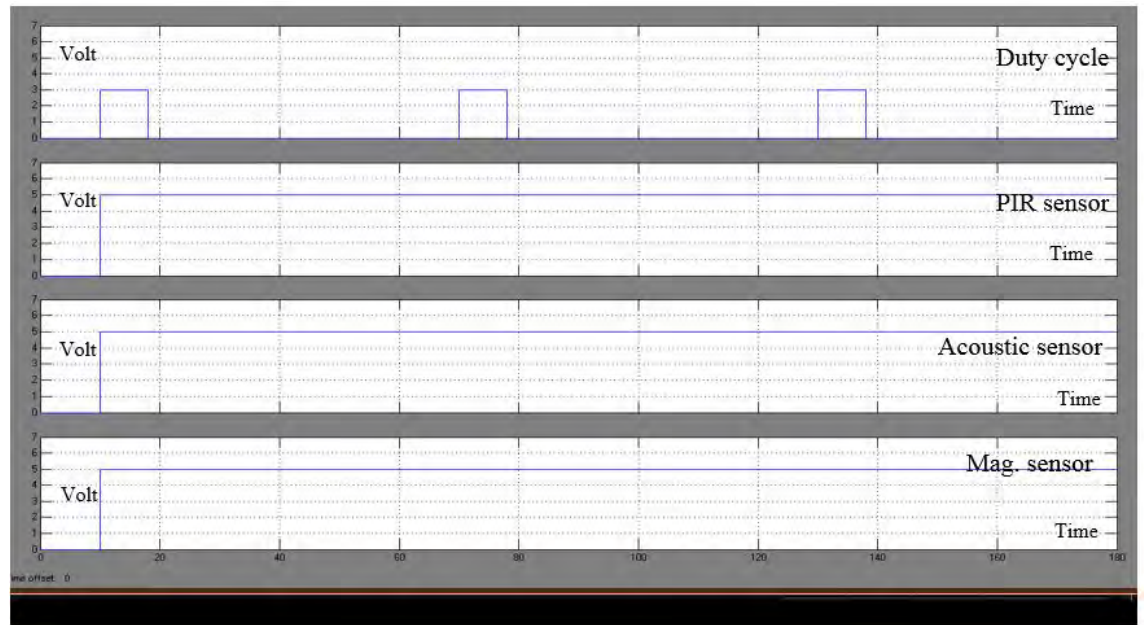
Figure 4. Scope1 (duty cycle and the output of PIR,acoustic, and magnetic sensors).